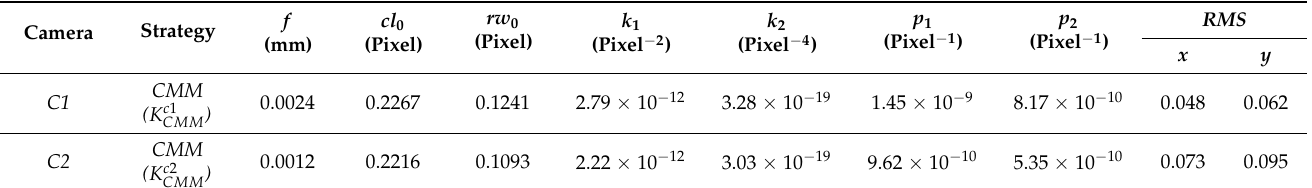
Table 2. The precision results (1-sigma) of the intrinsic parameters of each C camera for cube virtual grid